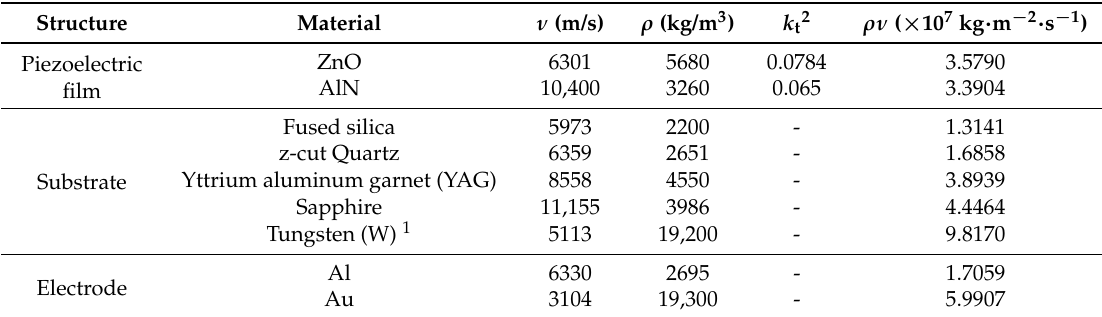
Table 1. Material parameters of composite resonators